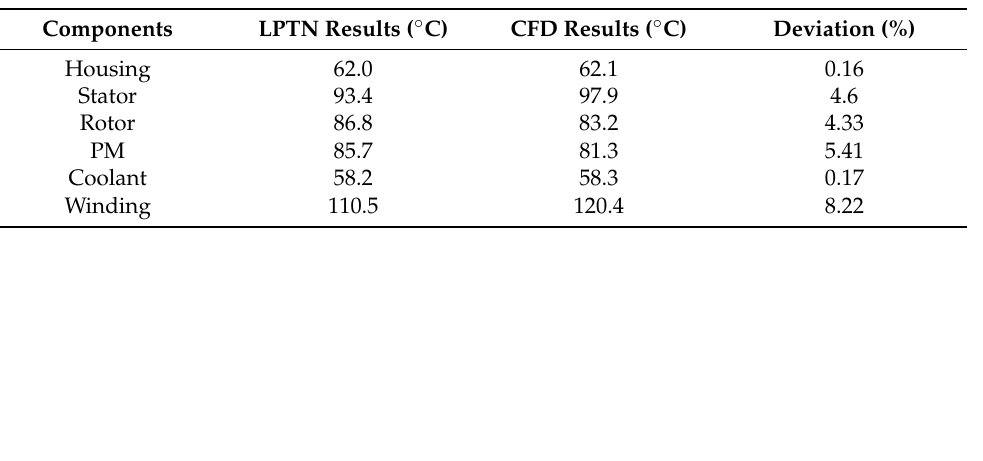
Table 5. Comparison of temperature calculation results under 1500 r/min @ 130